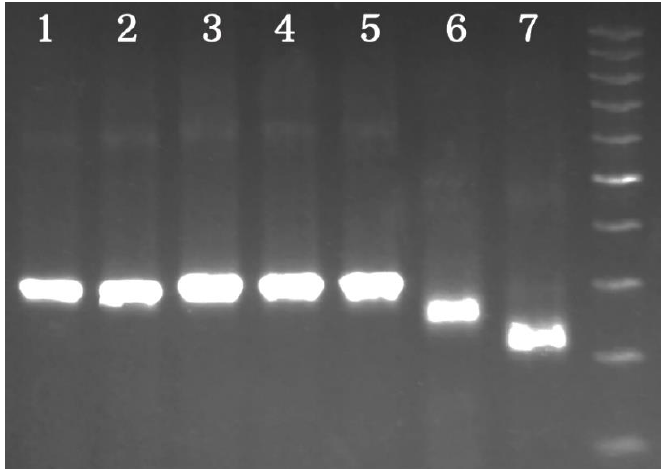
Figure 1. The results of the polymerase chain reaction (PCR) experiments with 5S1/5S2 in the Elaeagnus and Shepherdia species. The lines correspond to the samples in the follow order: (1) E. angustifolia , (2) E. commutata , (3) E. multiflora , (4) E. pungens , (5) E. umbellata , (6) Sh. canadensis , and (7) Sh. argentea . The molecular weight marker is 100